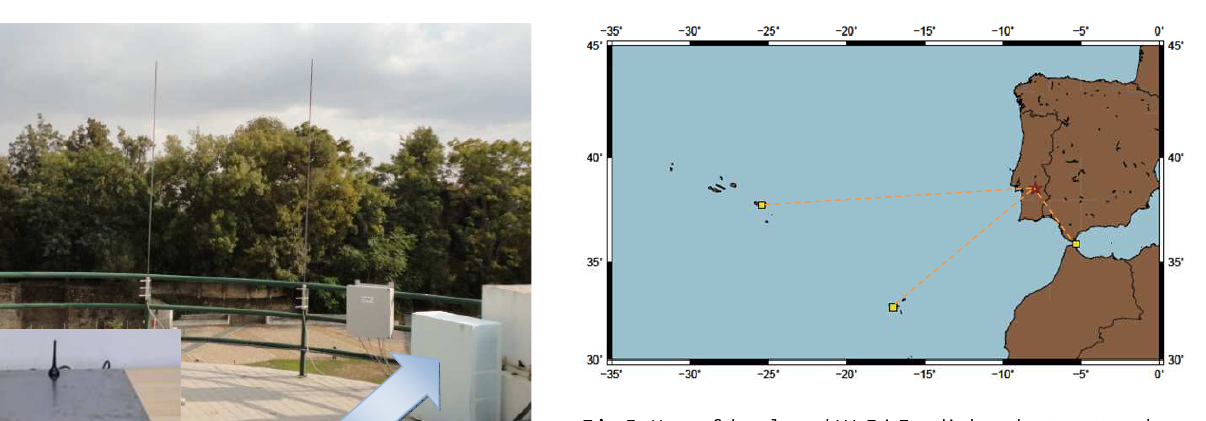
Fig. 5. Map of the planned VLF/LF radio broadcast system: three transmitters (represented by yellow squares) located at Azores (Por- tugal), Madeira (Portugal) and Ceuta (Spain), and the receiver (shown as a red star) installed at ´Evora